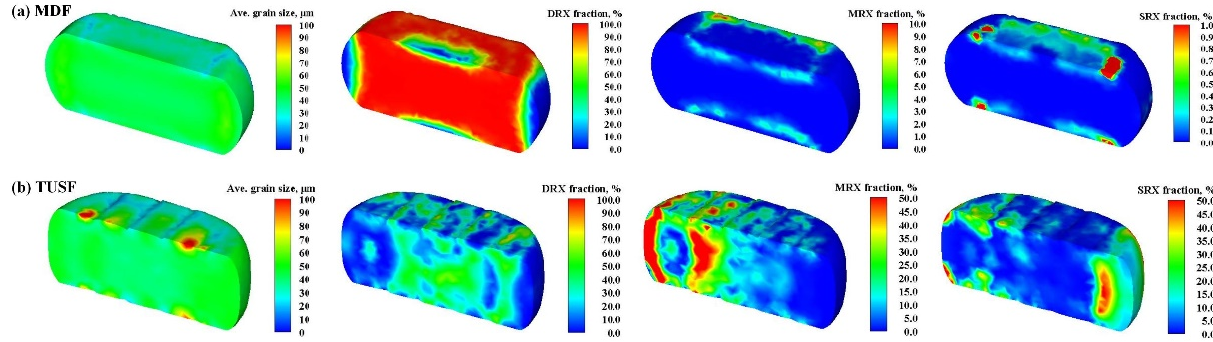
Figure 14. Schematic diagram of the microstructural distribution and recrystallisation behaviour after ( a ) MDF and ( b ) TUSF.